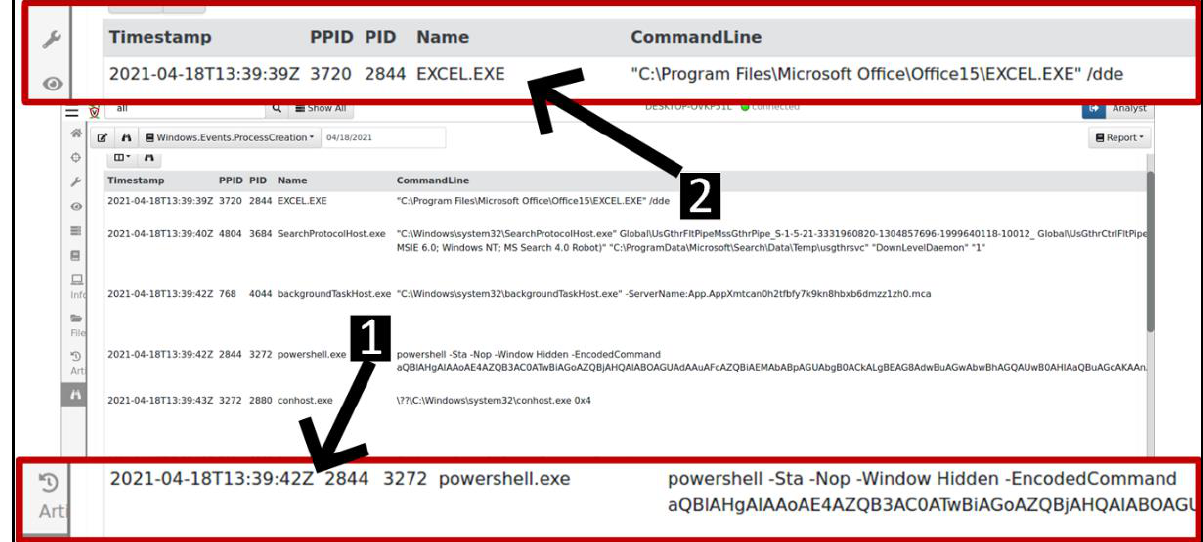
Figure 9. Velociraptor process creation events.